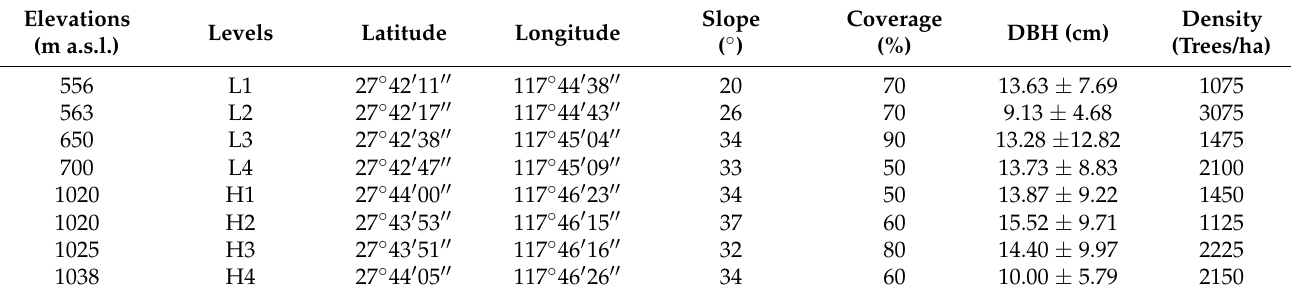
Table 1. General characteristics of forest